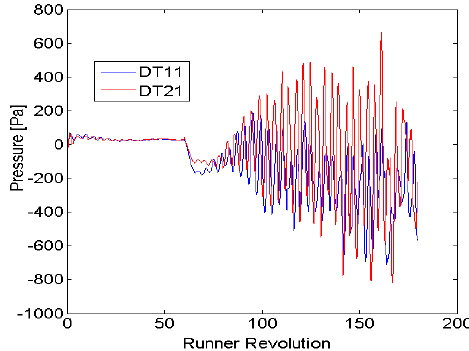
Figure 14. Comparison SST and SAS ‐ SST turbulence models used to simulate the draft tube flow; runner revolution from 0 to 60 corresponds to SST model, and from 61 to 180 corresponds to SAS ‐ SST model; DT11 and DT21 are the numerical monitoring points under part load operating conditions and correspond to the pressure sensor locations [6].